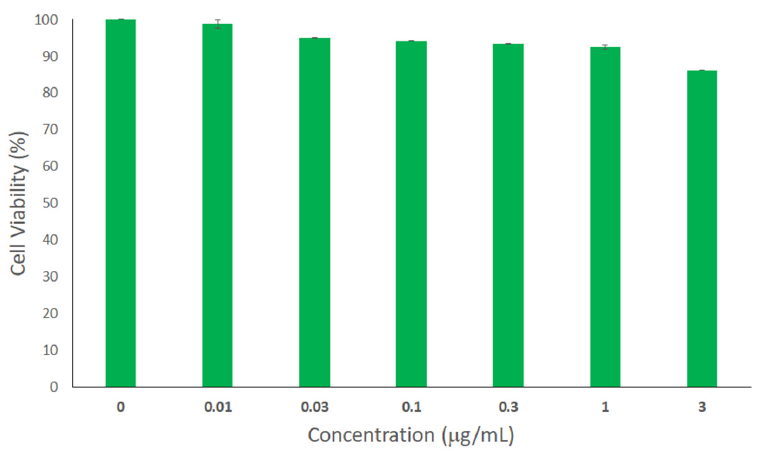
Figure 5. Evaluation of the cytotoxicity of the optimal H/CS/PLGA NPs at various